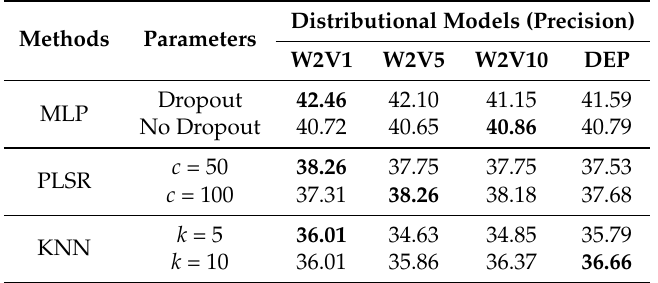
Table 4. The percentage average precisions for all methods.